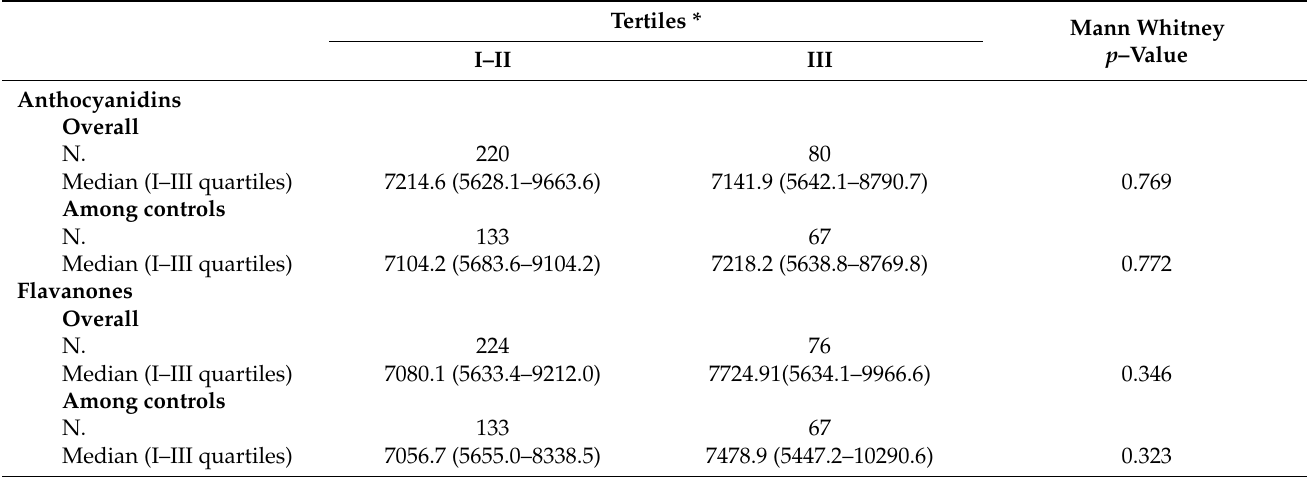
Table 4. Distribution of 16S rRNA gene copies in whole blood/ µ L, according to tertiles of anthocyani- din and flavanone intakes, overall and among controls. Italy